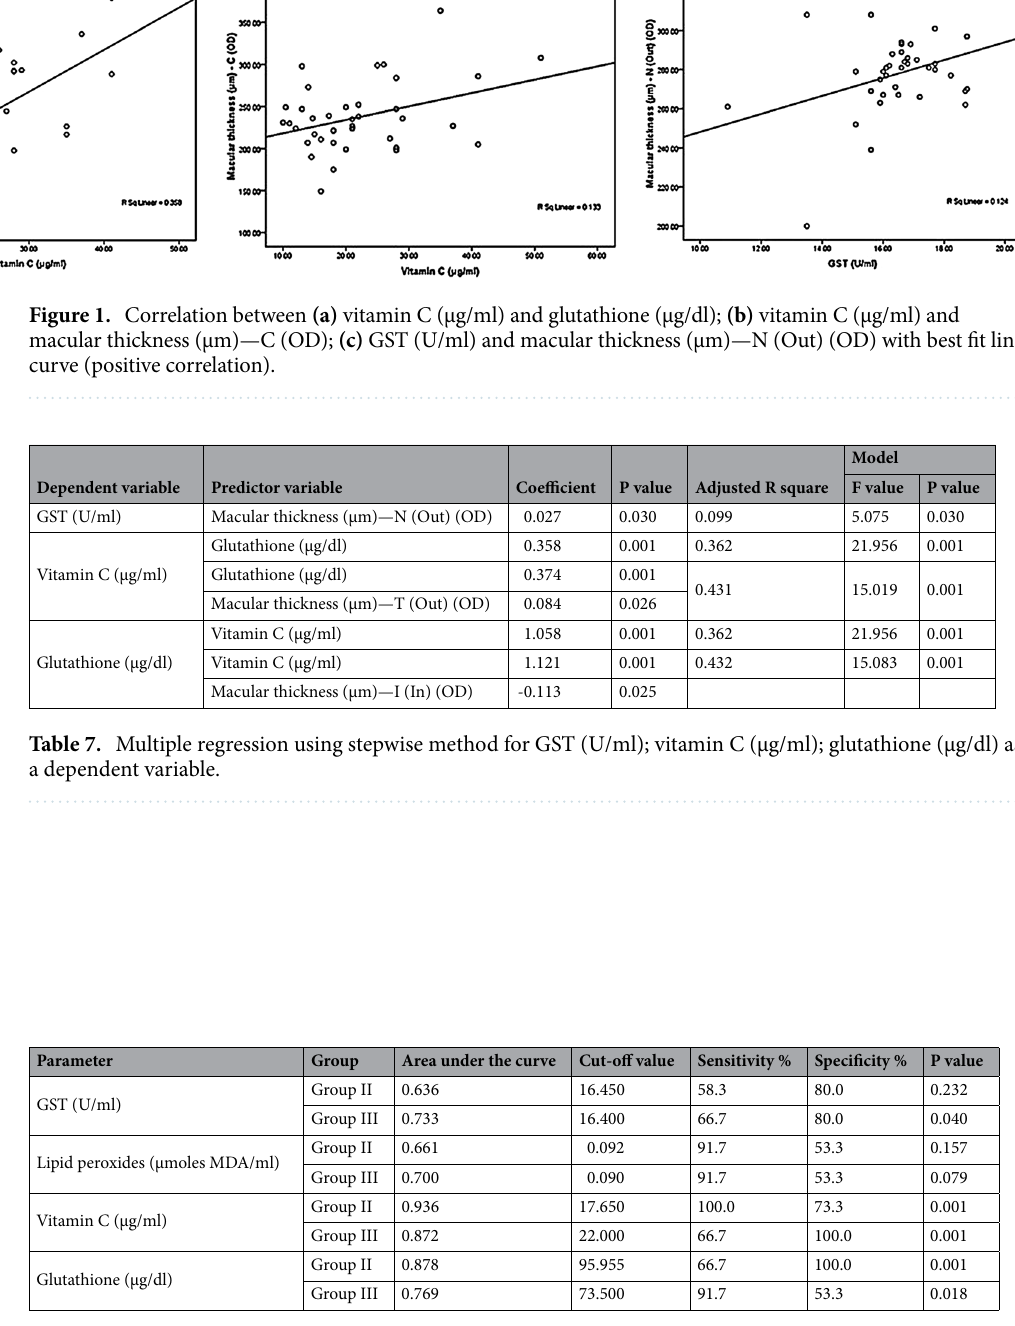
Table 8. ROC-curve of all parameters in all